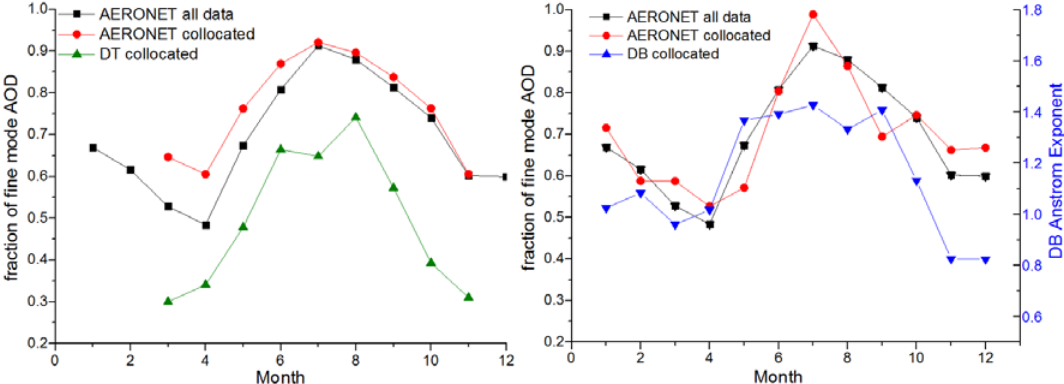
Figure 7. ( Left ) Comparison of AERONET fine AOD fraction at 500 nm (black), collocated AERONET (red) and MODIS DT fine mode aerosol fraction at 550 nm (green), ( right ) and DB Ångström exponent at 412 and 470 nm (blue) in Beijing.